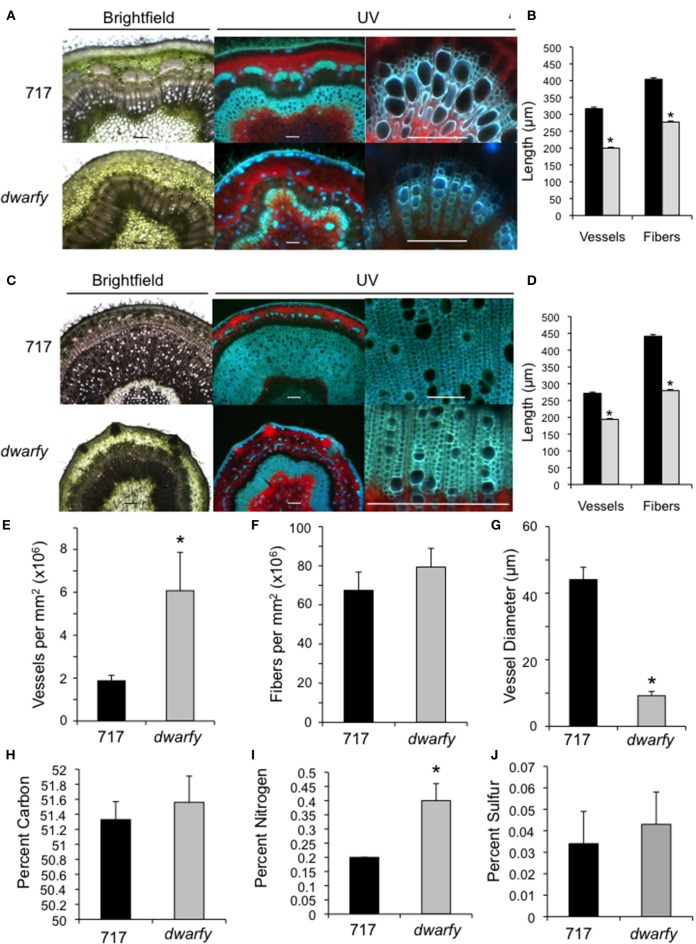
Elevated expression levels of PtaACS8 result in significant changes in stem architecture and physical characteristics. (A) Transverse cross section of wild-type and dwarfy stems at the leaf 10–11 internode as observed under brightfield and UV autofluorescence. Scale bar = 1 mm for first two images and 100 μm for the third panel (B) Vessel and fiber lengths of wild-type (black bars) and dwarfy (gray bars) stems between the leaf 10–11 internode. (C) Transverse cross section of wildtype and dwarfy stems at the leaf 20–21 internode as observed under brightfield and UV autofluorescence. Scale bar = 0.5 mm for first two images and 100 μm for the third panel. (D) Vessel and fiber lengths of wild-type (black bars) and dwarfy (gray bars) stems between the leaf 20–21 internode. Vessel (E) and fiber (F) density in wild-type and dwarfy stems between the leaf 20–21 internode. (G) Vessel diameter in wild-type and dwarfy stems between the leaf 20–21 internode. Relative percentage of carbon (H), nitrogen (I) and sulfur (J) in the stems of wildtype and dwarfy. All values ±Standard Error. *Significantly different from wildtype (p < 0.05).